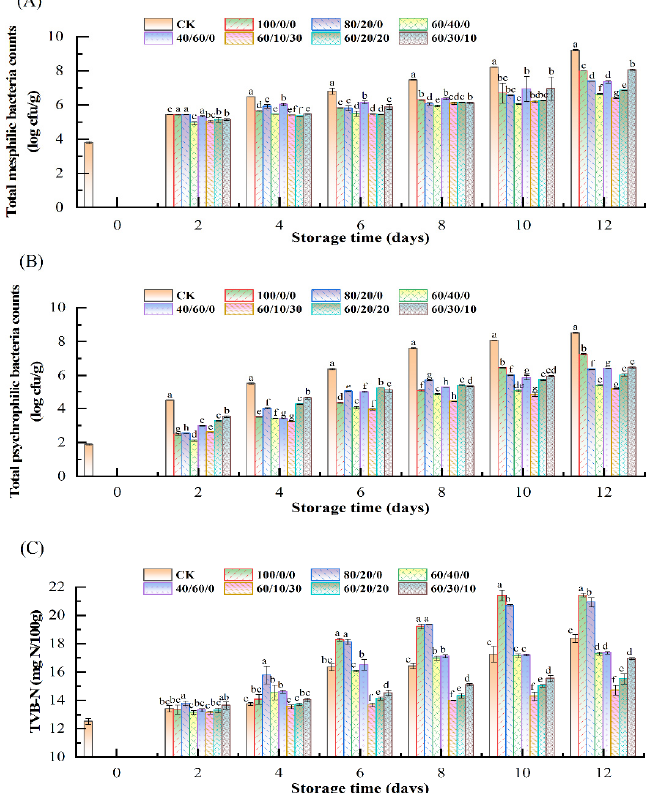
Figure 2. Changes of total mesophilic bacteria ( A ), the total psychrophilic bacteria ( B ), and TVB-N ( C ) in salmon fillets under MAP containing different CO 2 /O 2 /N 2 ratios during storage at 4 °C. Different lowercase letters (a–h) represent significant differences ( p < 0.05) between different groups at the same storage period. The changes of total psychrophilic bacteria count of salmon packaged under different concentrations of CO 2 and O 2 are shown in Figure 2B. The TPB counts of the control rose from 1.87 log cfu/g to 8.52 log cfu/g during storage. Compared with the results of TMB, it is demonstrated that the proportion of psychrophilic bacteria to mesophilic bacteria was low initially, but increased during storage, in agreement with the study of Yang et al. [24]. The pattern change of TPB was similar to TMB, and 60%CO 2 /10%O 2 /30%N 2 had the lowest TPB counts. Therefore, 60%CO 2 /10%O 2 /30%N 2 was recommended according to the results of bacterial growth.